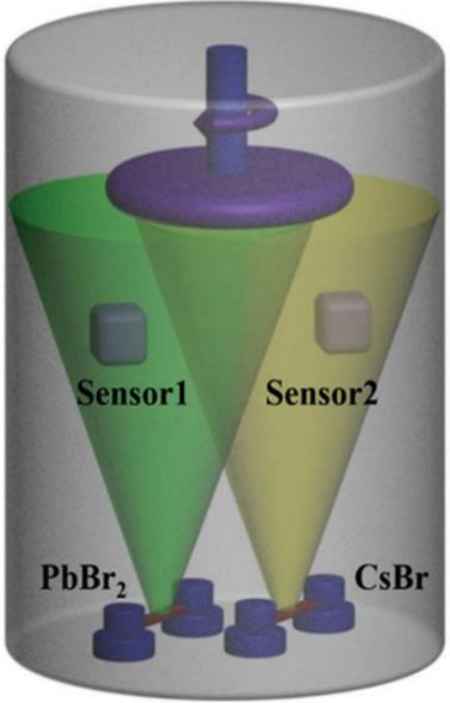
Figure 1. Schematic diagram of the DSVE method [26].